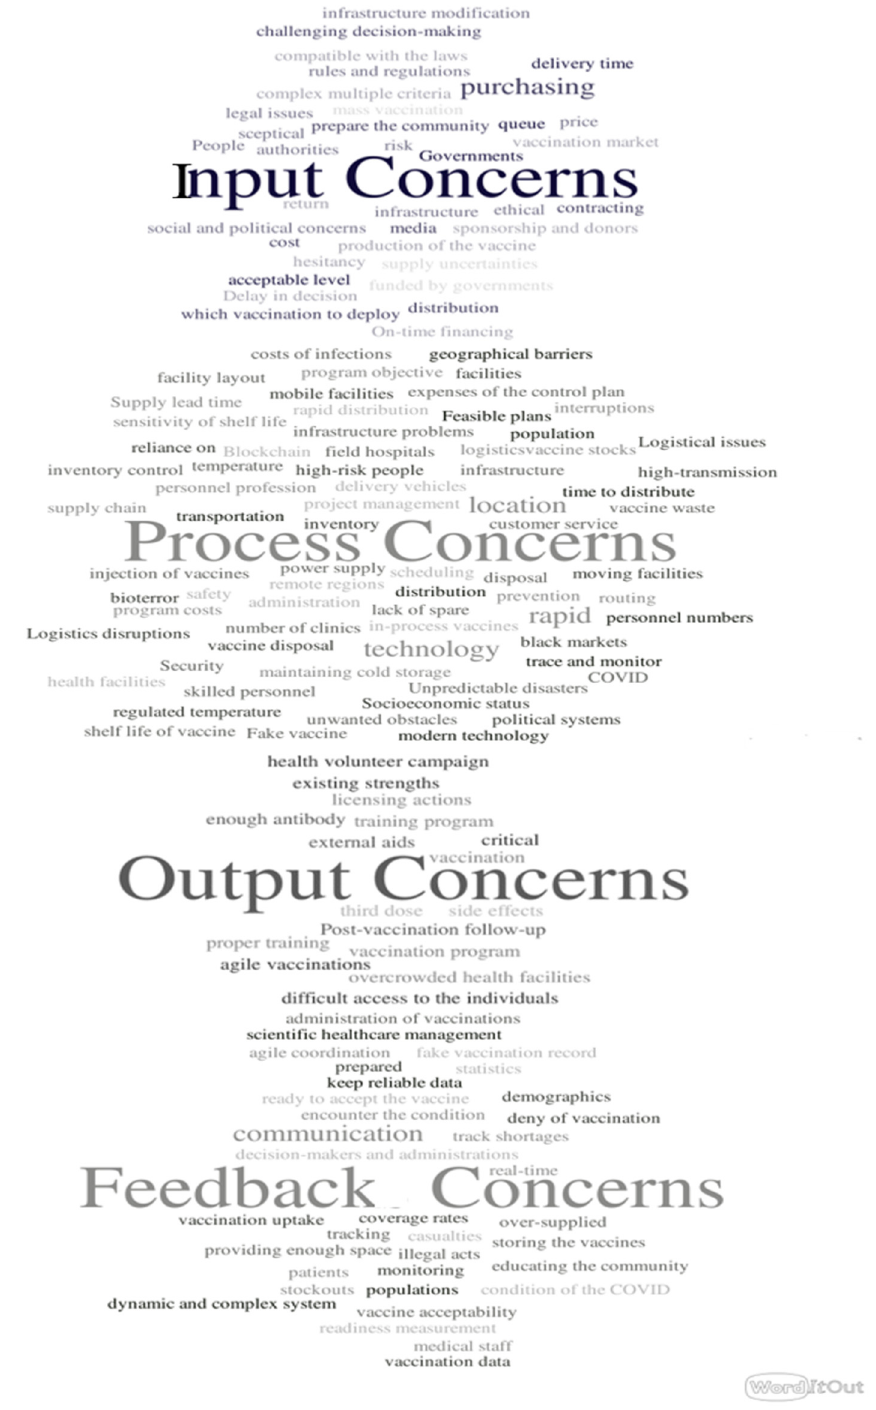
Figure 2. Visualization of concerns via a system approach.